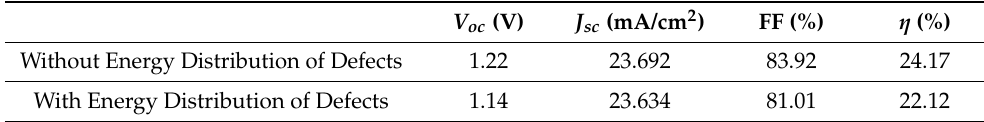
Table 1. Device output characteristics with adoption of energy distribution of defects.